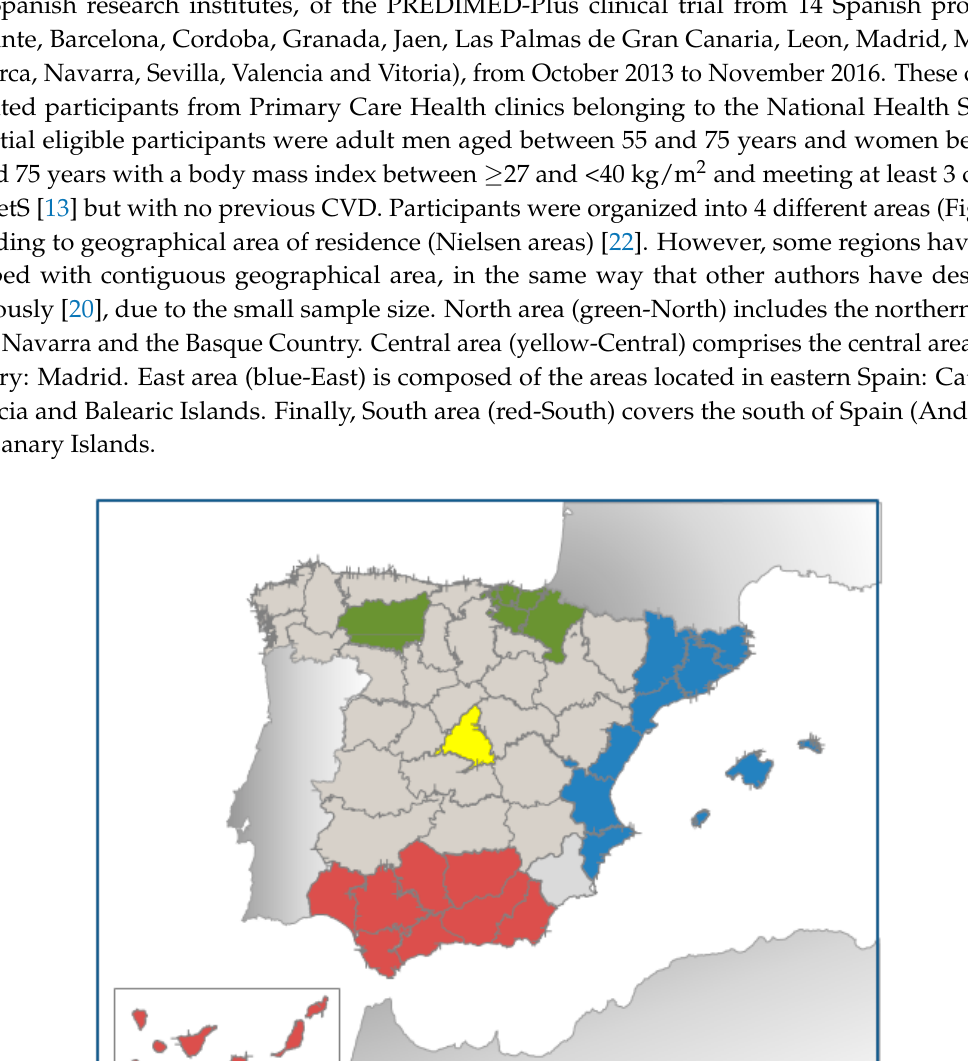
Figure 2. Flow-chart of participants. 2.3. Assessment of Dietary Intake Trained nutritionists collected baseline food intake data in their baseline interview using the PREDIMED FFQ, which has been previously validated in Spanish subjects [26,27]. The FFQ included 143 food items, arranged into 11 food groups, taking into account the similarities of their nutrient profiles (vegetables, fruits, legumes, cereals, milk and dairy products, meat and meat products, fish and seafood, olive oil, nuts, sugars and sweets and eggs). The FFQ includes 9 possible answers for consumption frequency ranging from never/seldom to >6 servings/day. The indicated frequencies of consumption were converted to intakes per day and multiplied by the weight of the portion size indicated by the participant and expressed as grams per day [28]. Nutrient information was derived using Spanish food composition tables [29,30]. Subjects were asked about MedDiet adherence via a